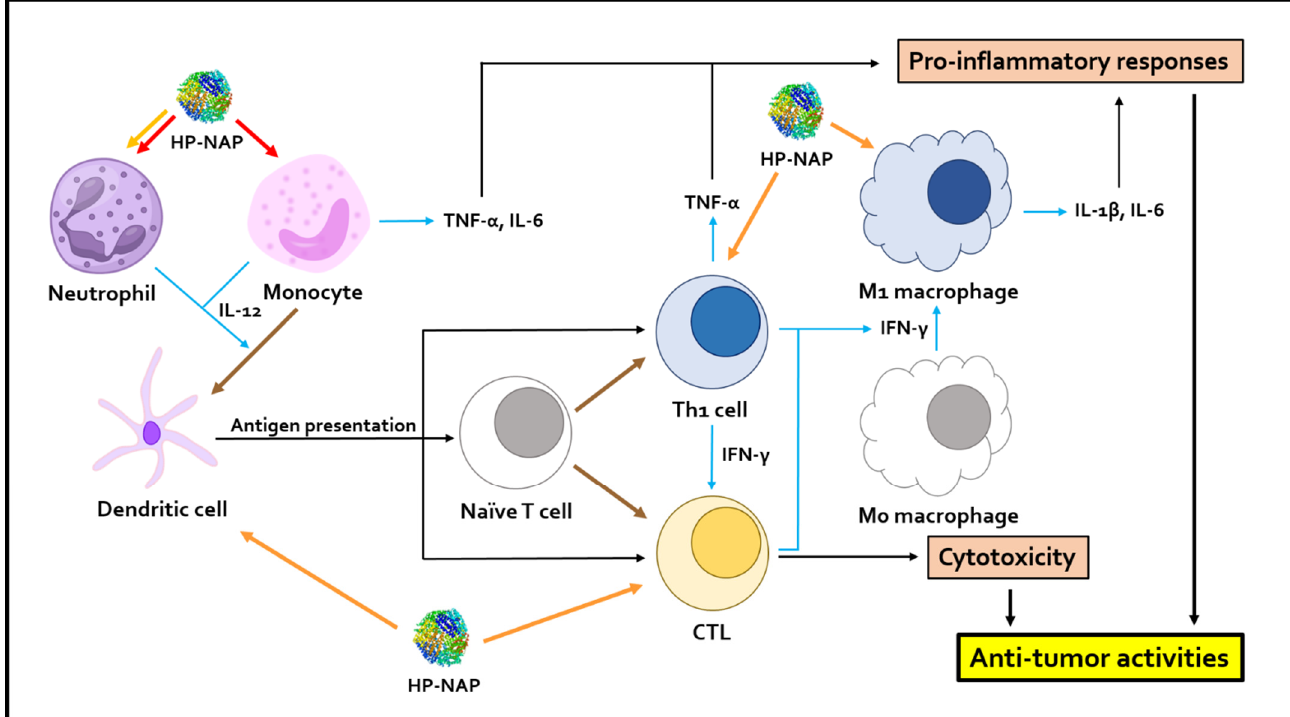
Figure 3. Schematic presentation of how HP-NAP promotes anti-tumor immune responses by inducing pro-inflammatory responses and CTL activity. HP-NAP directly activates neutrophils and monocytes to induce the secretion of IL-12. Activated monocytes also secrete TNF- α and IL-6 to promote anti-tumor inflammatory responses. The release of IL-12 could promote the differentiation of monocytes into dendritic cells (DCs). Mature dendritic cells promote the differentiation of naïve T cells into Th1 cells by antigen presentation, and further lead to the release of Th1 cytokines, such as IFN- γ and TNF- α , from Th1 cells. The polarization of M1 macrophages could be promoted by IFN- γ . M1 macrophages secrete IL-1 β and IL-6 into tumor microenvironments and enhance inflammation responses. Antigen presentation, mediated by DCs, and Th1 cytokines could promote the differentiation and activation of CTLs to mediate anti-tumor immunity. HP-NAP also induces the infiltration of neutrophils, M1 macrophages, antigen-presenting DCs, Th1 cells, and CTLs into tumor microenvironments. “ ↓ ” indicates induction; red arrows indicate the direct stimulation of the cells by HP-NAP; orange arrows indicate the stimulation of cell infiltration by HP-NAP; blue arrows indicate stimulation of cellular activity; brown arrows indicate differentiation. HP-NAP, H. pylori neutrophil-activating protein; Th1, T-helper type 1; CTL, cytotoxic T lymphocyte; IL-1 β , interleukin-1 β ; IL-6, interleukin-6; IL-12, interleukin-12; IFN- γ , interferon- γ ; TNF- α , tumor necrosis factor- α .